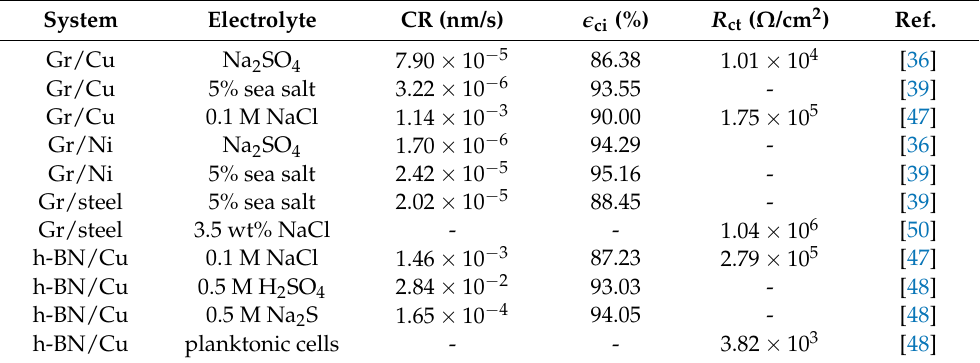
Table 1. Corrosion rates (CR), corrosion-inhibition efficiencies ( (cid:101) ci = i bare − i coat various CVD 2D coatings grown on metal substrates in different electrolytes.